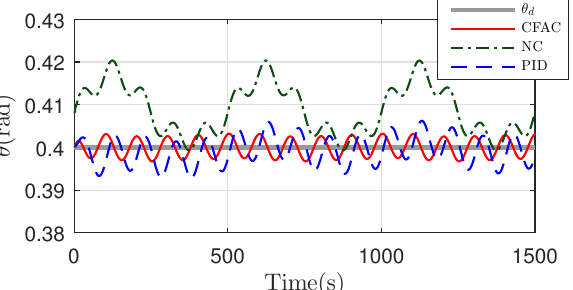
Figure 17. Velocity tracking error in floating motion with a variable velocity and constant pitch angle command.